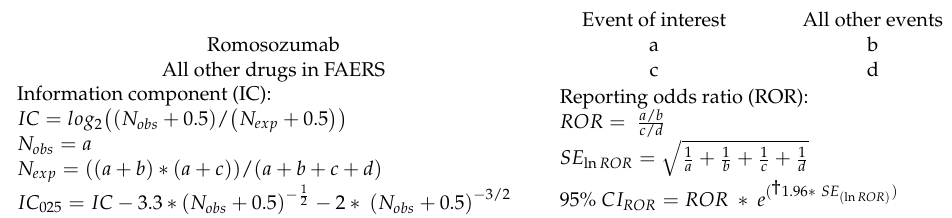
cardiovascular drugs as either suspect, concomitant, or interacting, Table S3: Demographic Table S4: Disproportionality analysis of outcomes of interest among cases with a reported age of 50 years or older. Table S5: Disproportionality analysis of all outcomes of interest, stratified by case sex and reporting